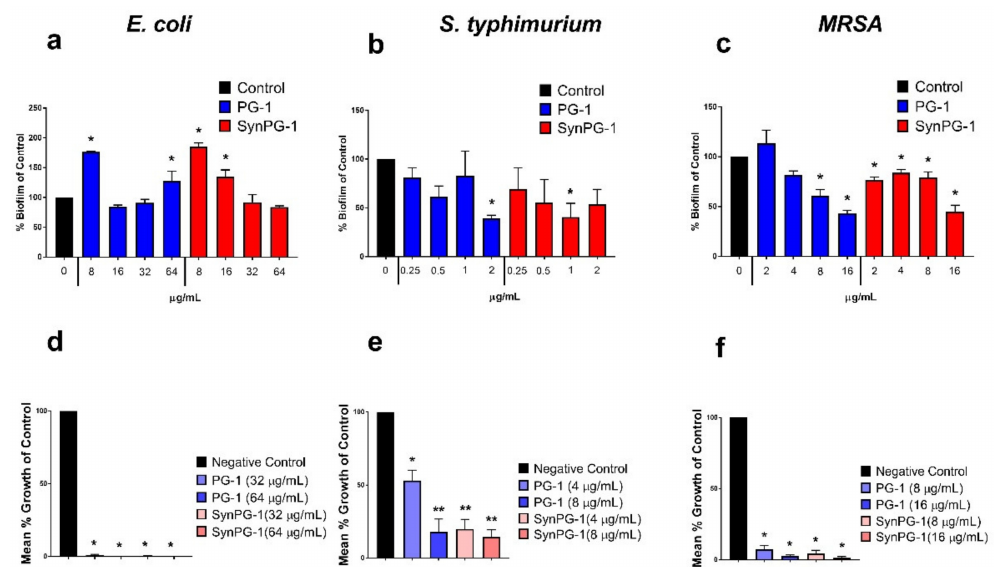
Figure 5. E ff ect of PG-1 and SynPG-1 on inhibition of biofilm formation of ( a ) E. coli , ( b ) S. typhimurium , and ( c ) MRSA, represented as the mean ± SEM of % biofilm of control of three independent experiments, where n = 6. The asterisks represent significant di ff erences at p < 0.05 when compared to the control by two-way ANOVA with a post hoc Tukey test. The e ff ect of PG-1 and SynPG-1 on the viability of ( d ) E. coli , ( e ) S. typhimurium , and ( f ) MRSA colonies, represented as the mean ± SEM of the relative mean % growth of control of three independent experiments performed in duplicate. The asterisks represent significant di ff erences at p < 0.05 (*) or p < 0.01 (**), when compared through one-way ANOVA with a post hoc Tukey